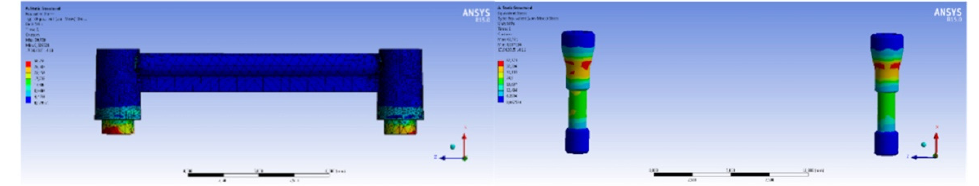
Figure 4. The distribution of Von Mises stress after vertical loading on Model 1 bar attachment and screw.